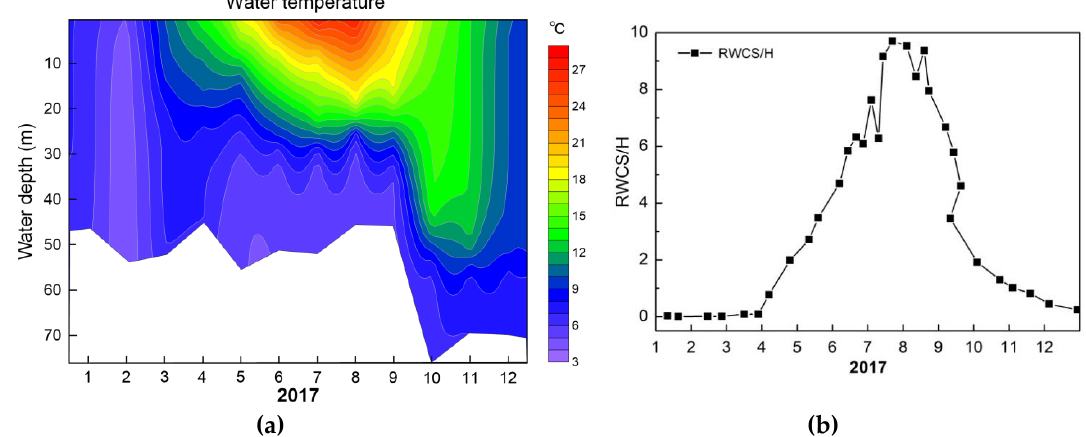
Figure 4. Seasonal water temperature depth profile of S1 site ( a ), thermal stratification index RWCS/H ( b ) in Lijiahe Reservoir in 2017.